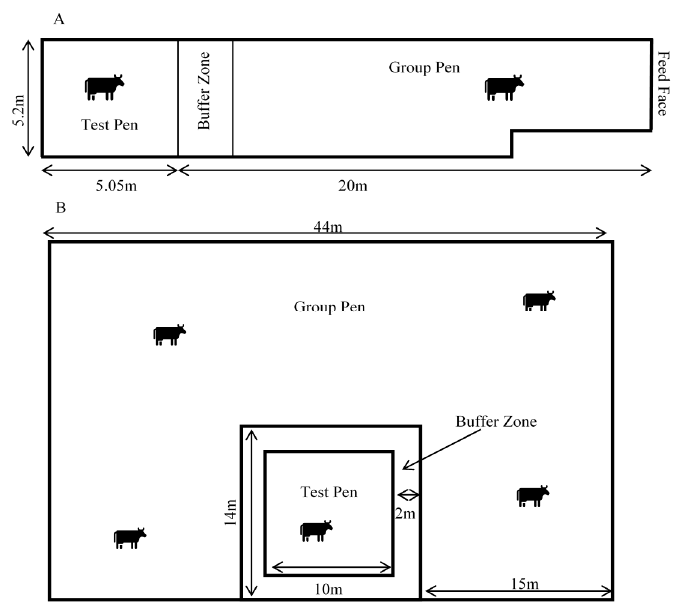
Figure 1. Diagrams of group and test pen design in the Scottish indoor-housed study ( A ) and in NZ outdoor pasture study ( B ). During recordings, the test cow was moved into the test pen. When not recording, the cow was moved back into to the group pen.